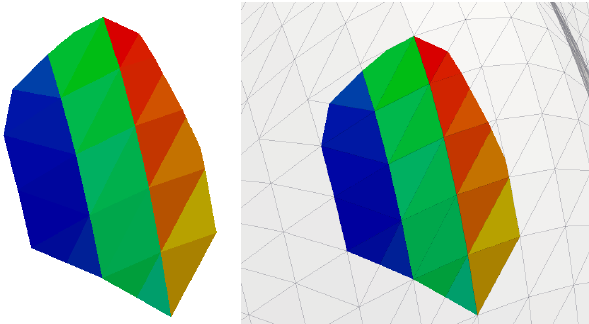
Figure 6. Reference patch ref j on the original DEM surface of an initial Voronoi cell, with the centre at r i (left). ref j on the original DEM surface oriPd (right).